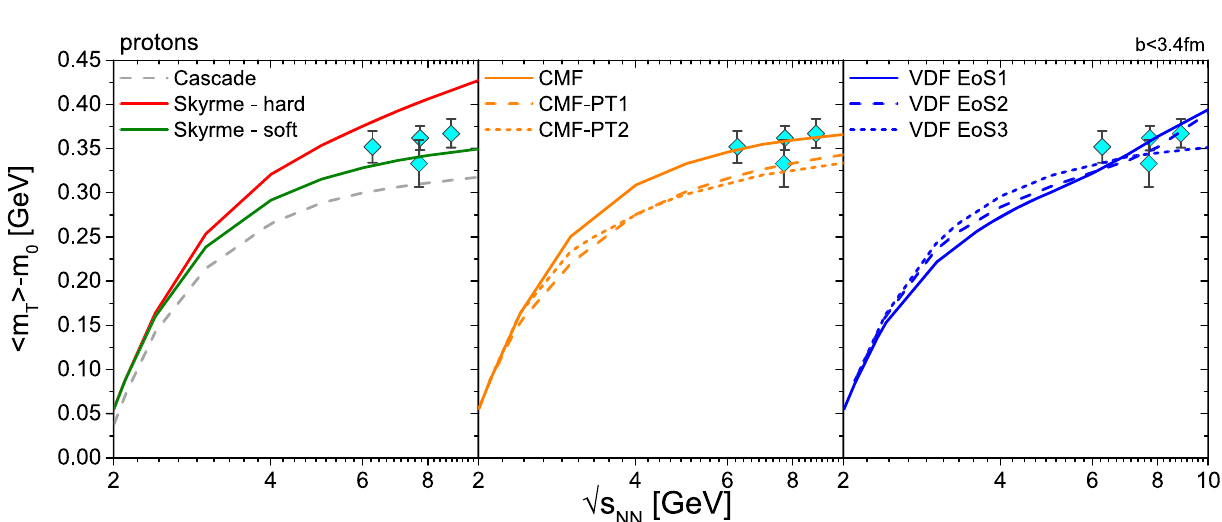
Fig. 3 The mean transverse kinetic energy (cid:8) m T (cid:9) − m 0 of protons for central Au–Au collisions. (cid:8) m T (cid:9) is evaluated at mid-rapidity | y cm / y b | < 0 . 1 ( y is the proton rapidity in the center of mass frame of the collision, i.e. y cm = 0, and y b is the beam rapidity defined in the center-of-mass frameofthecollision)andnocutinthetransversemomentumisapplied.